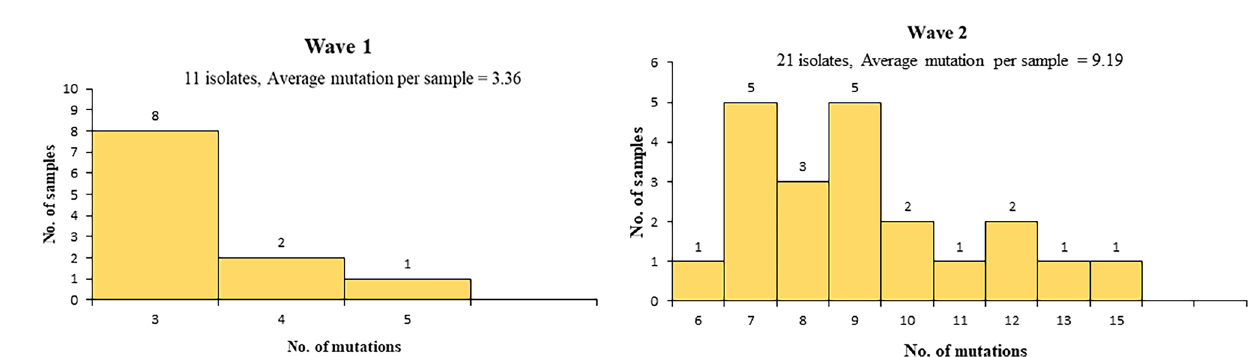
Figure 3. Graph representing the number of mutations per sample for wave 1 and wave 2. The average mutations per sample observed in wave 1 is 3.36 for 11 isolates and in wave 2 is 9.19 for 21 isolates.